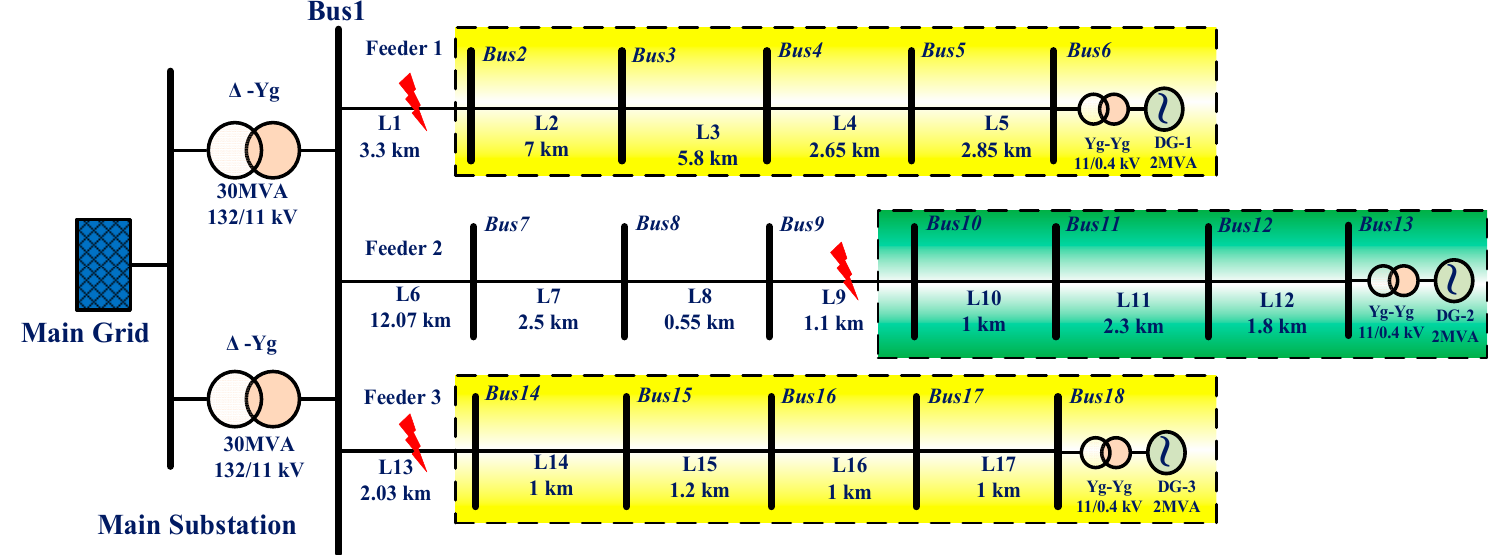
Figure 8. A single line diagram for a practical 18-bus-bar distribution network.